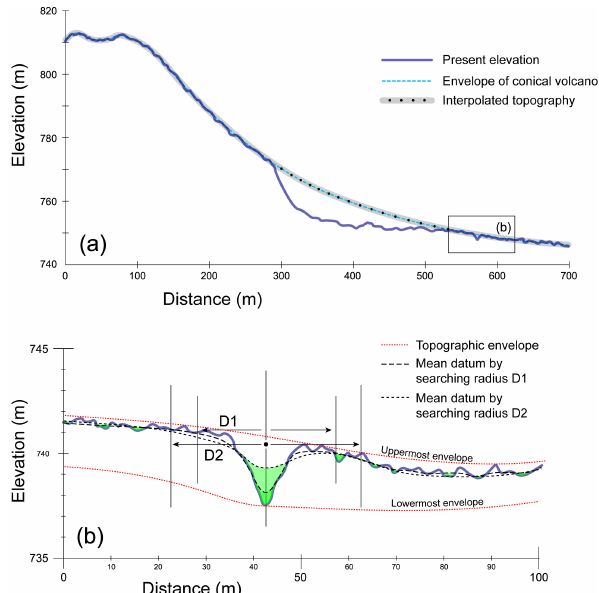
Figure 9. Schematic illustration showing how the envelope of pa- leomorphology was obtained from the current DTM morphology. (a) The configurations of the undisturbed volcanic dome and cur- rent profile. The undisturbed volcanic dome facilitates the selection of manual interpolation points that better fit the volcanic edifice. (b) The configuration of the possible mean paleodatum correspon- dent to the other two enveloping surfaces. The shaded area repre- sents the river incision. D1 and D2 correspond to different radii for topographic regression and restoration. The idealized profile was simplified and modified from a part of topographic profile P4.